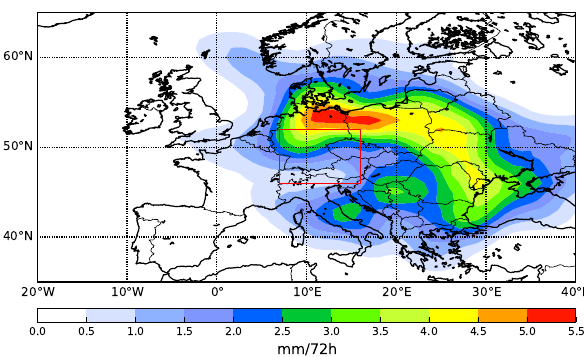
Figure 4. Evaporative moisture sources for precipitation in the red box during the 3 day core period of the heavy precipitation event from 31 May 2013, 00:00UTC to 3 June 2013, 00:00UTC (shading, showing moisture uptake in